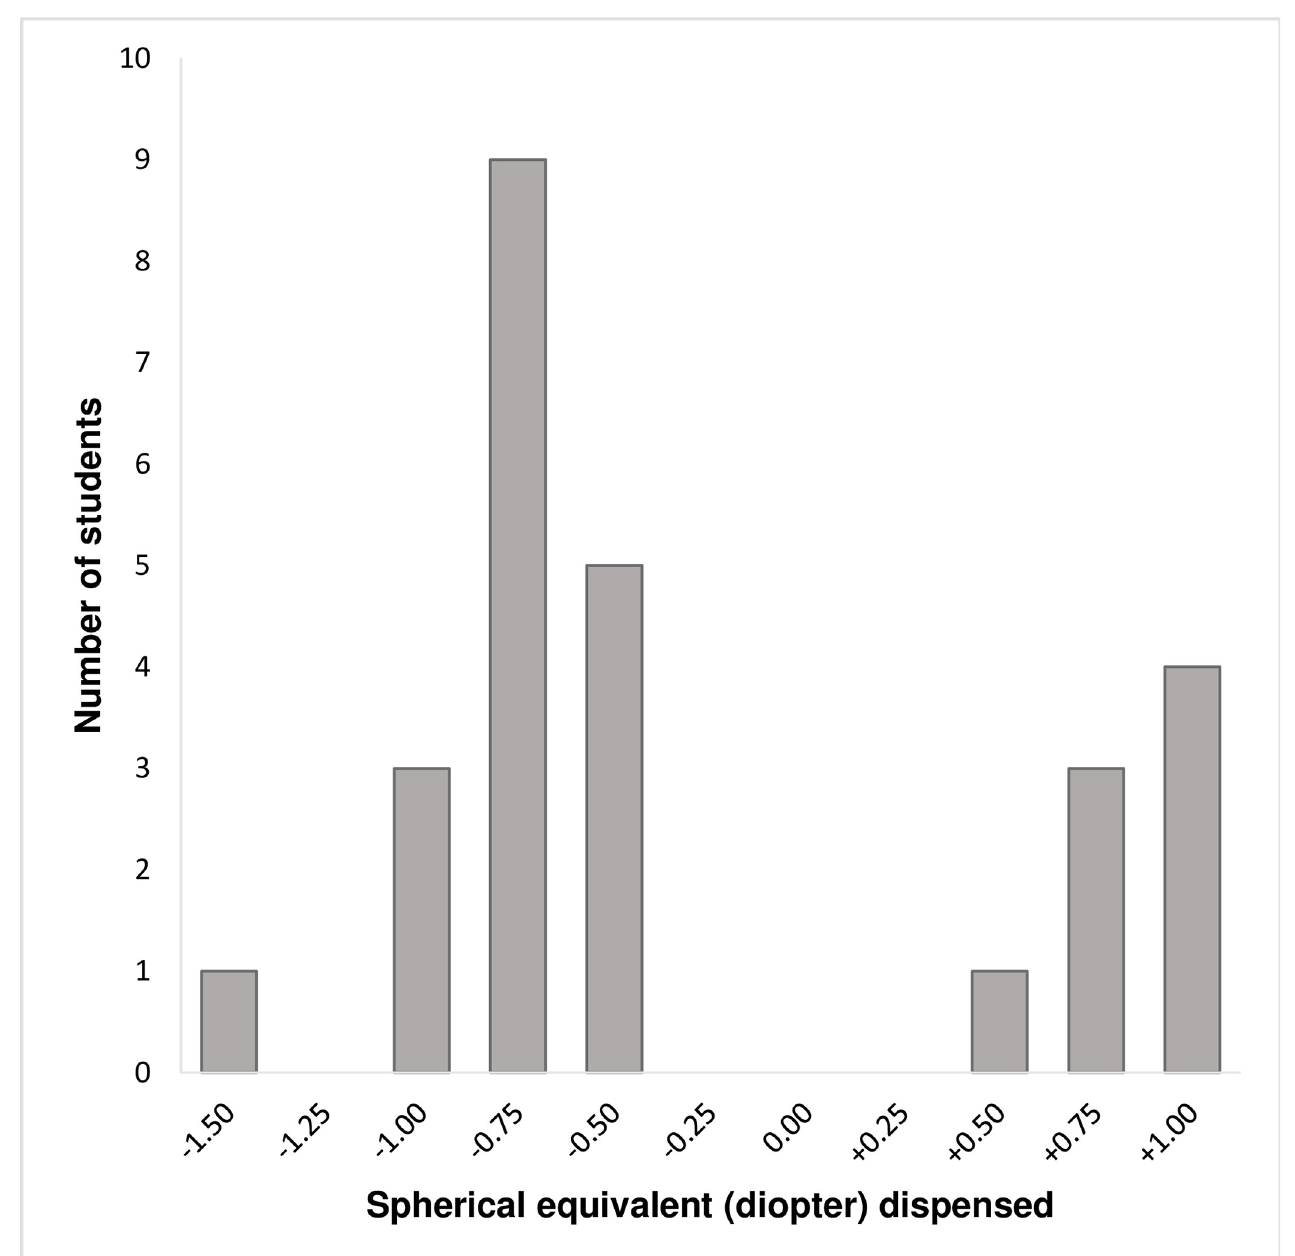
Fig 2. Range of spherical equivalent power